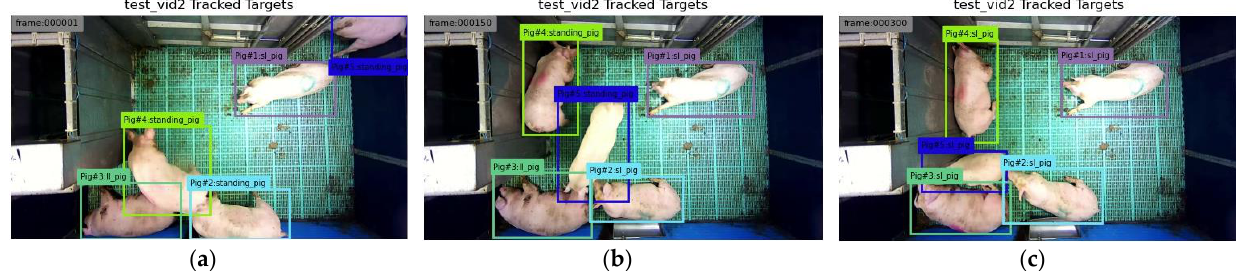
Figure 11. Sample of pig posture detection under various conditions by two models: ( a – c ) by YOLOv4 model for the frame having sparsely located pigs, frame having densely located pigs, and the frame having occlusion, respectively, and ( d – f ) by Faster R-CNN model for the same frames applied in the YOLOv4 model. Figure 12. Sample of tracked frames by the tracking algorithm: ( a ) the first frame, ( b ) the 150th frame as Pig 5 is moving, and ( c ) the 300th frame where Pig 5 has changed its posture from standing to sternal lying.